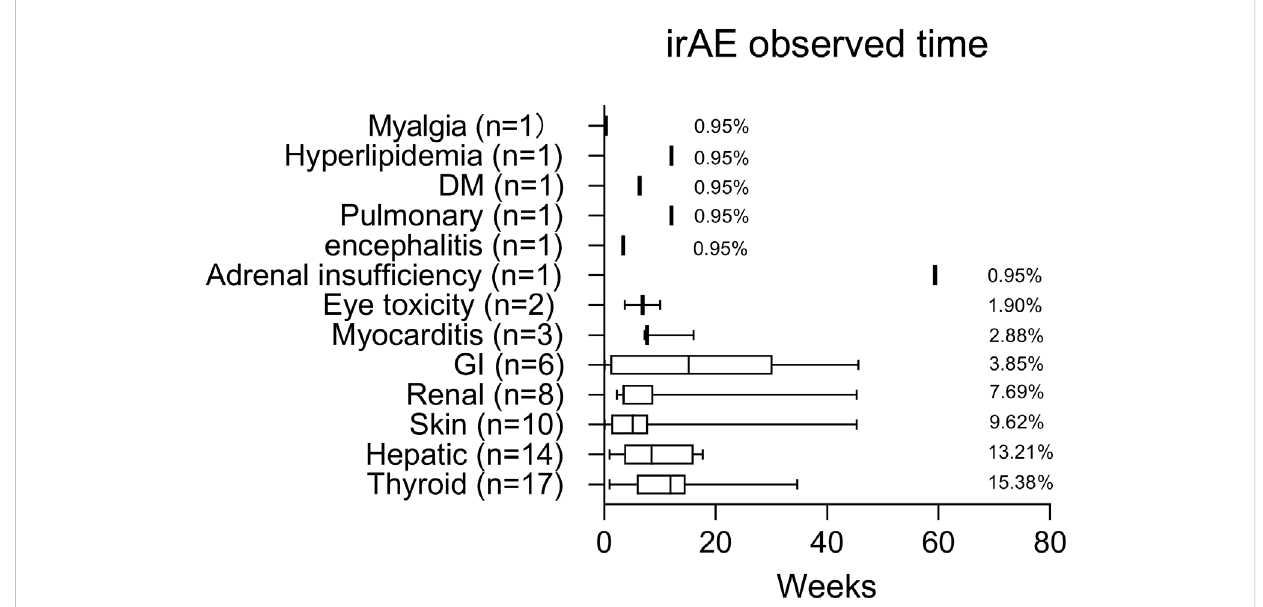
Median time (weeks) to irAE occurrence in PD-1-treated liver cancer